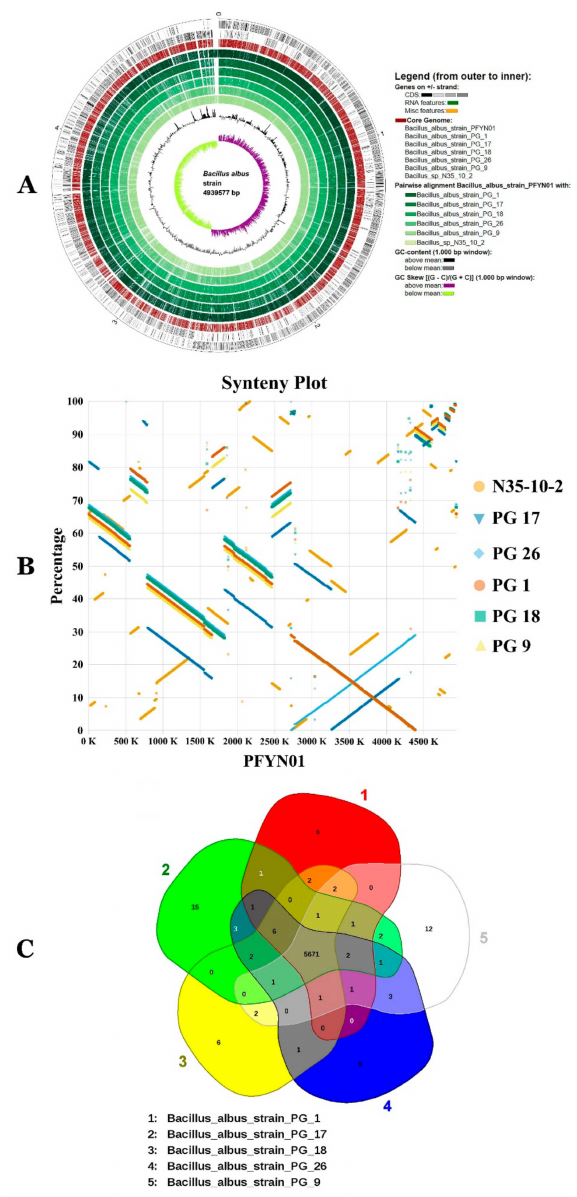
Figure 9. Circular genome comparison ( A ), synteny plot ( B ) and Venn diagram ( C ) showing overlap between common Bacillus albus strains